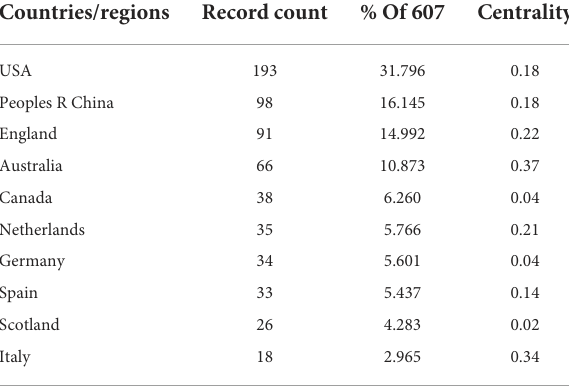
TABLE 2 The top ten productive countries or